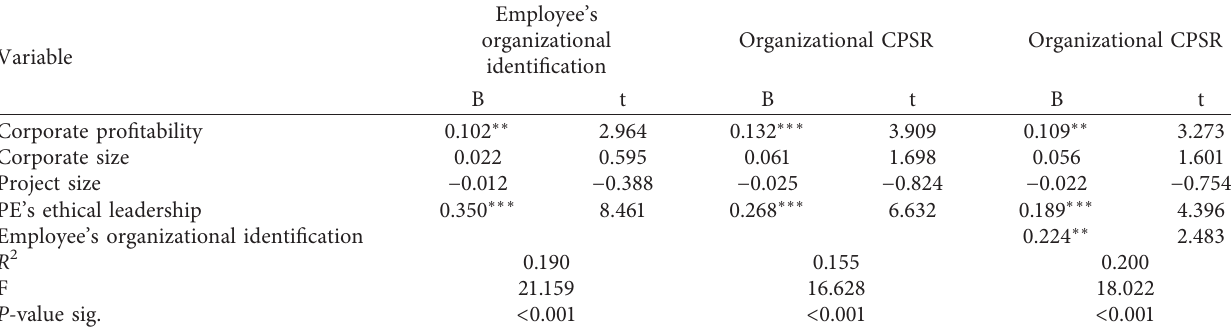
Table 4: Results of mediation analyses.